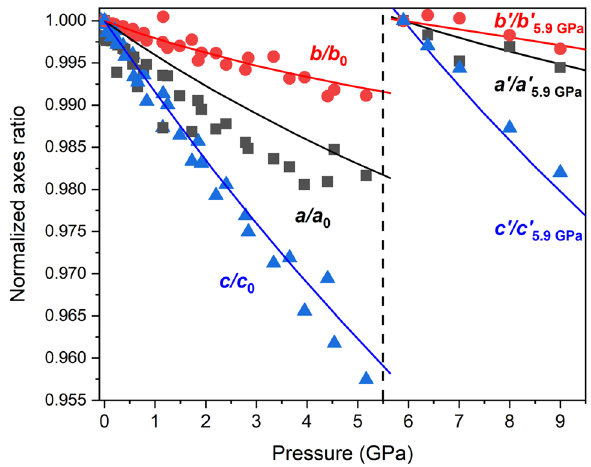
Figure 3. Normalized lattice parameters of BaCa(CO 3 ) 2 barytocalcite and HP post-barytocalcite phases as a function of pressure, which provide the information on axial compressibilities.